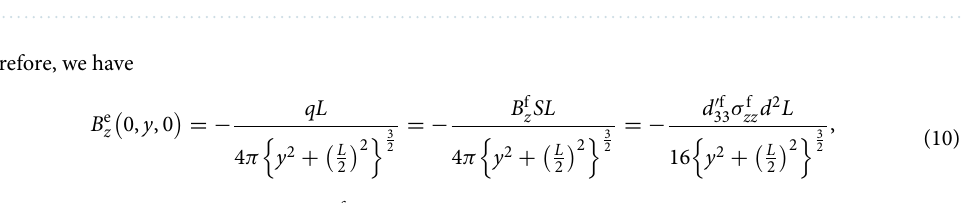
Figure 2. ( a ) The Fe–Co fiber and the magnetic flux density, ( b ) the magnetic charges, ( c ) magnetic flux density induced by two magnetic charges at point A, and ( d ) z -component of the magnetic flux density induced by magnetic charges at point